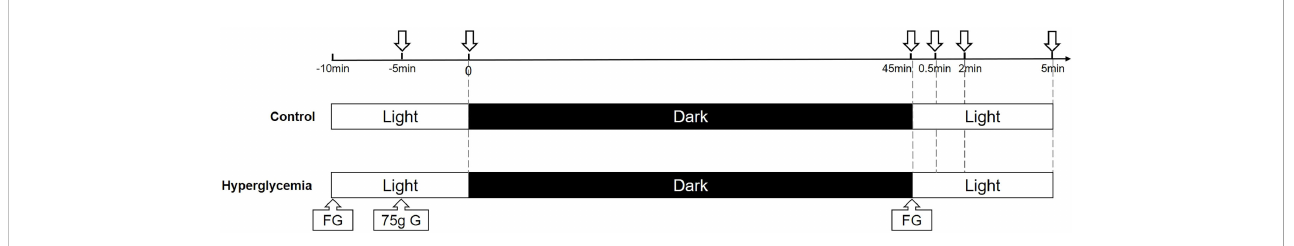
FIGURE 2 A schematic of dark and light adaptation image acquisition. Images were acquired at baseline in ambient light, after 45 min of dark adaptation, and at several time points (30 s, 2 min, 5 min) after transitioning from dark to ambient light in the control and hyperglycemia conditions. FG, fi nger blood sugar; G, glucose.